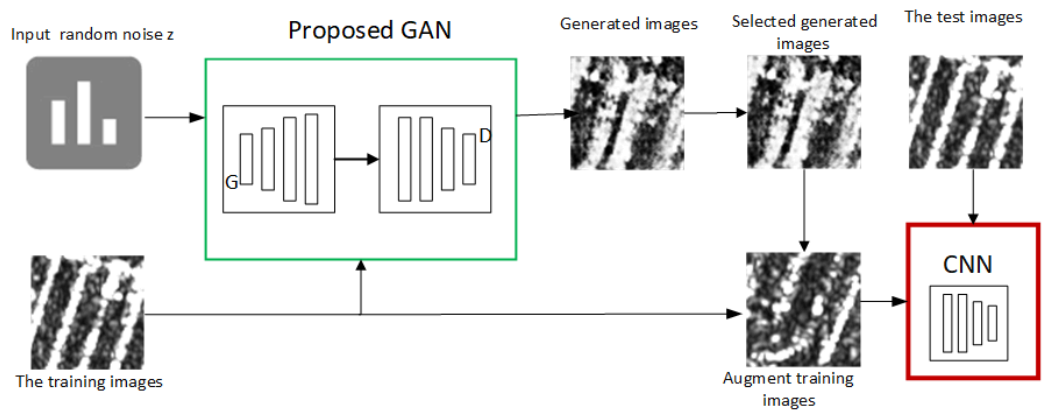
Figure 7. Overview of our framework.